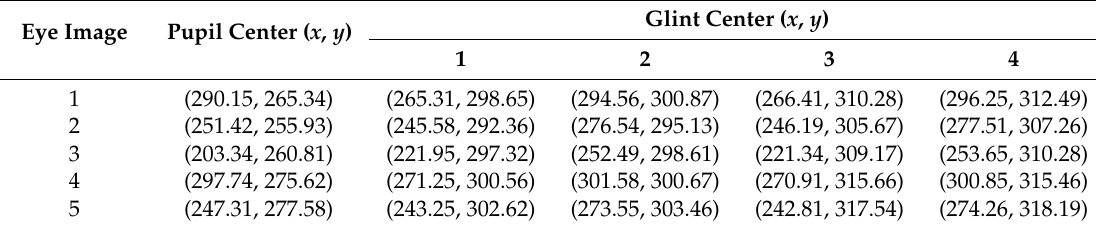
Table 1. A sample of the pupil and glint centers.